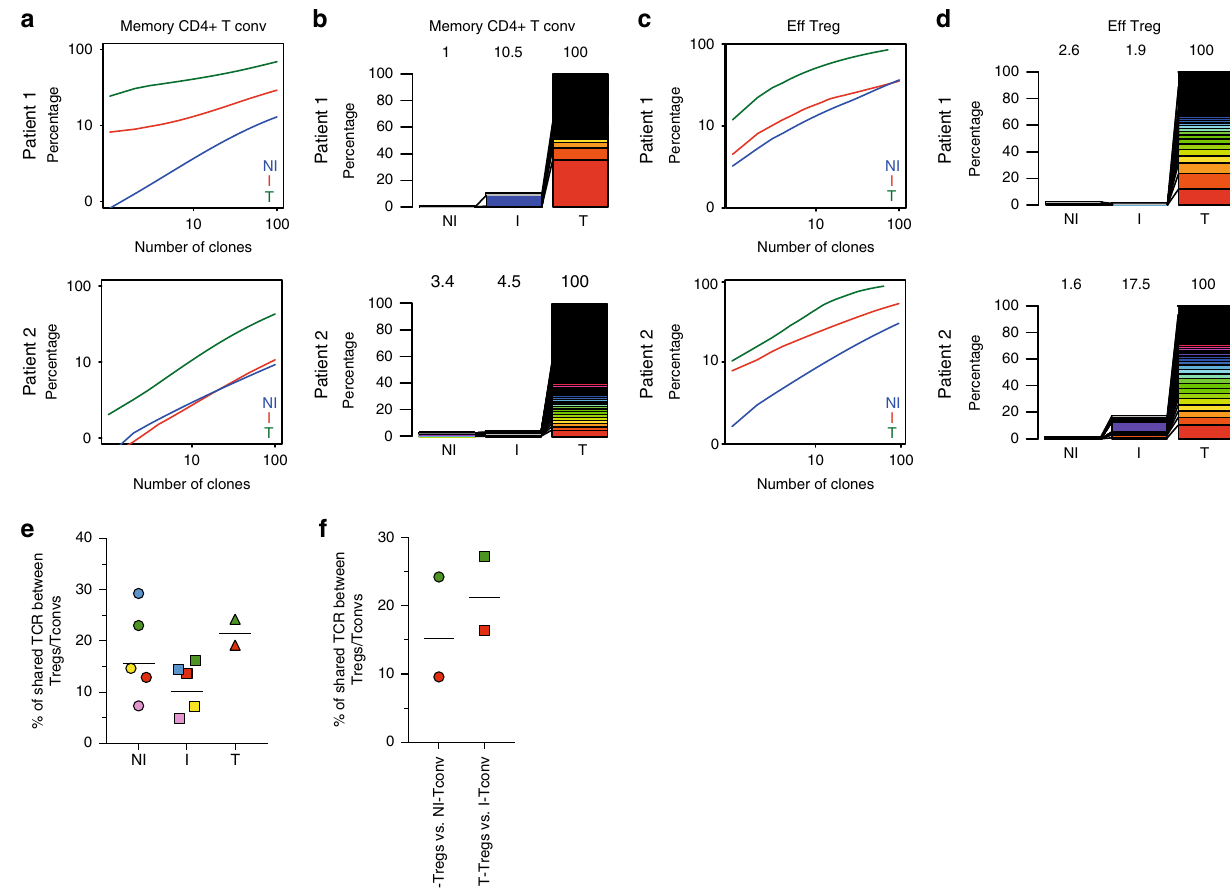
Fig. 5 Analysis of the TCR repertoire of CD4 + Tconvs and Tregs from NI and I TDLNs, and tumor. Next-generation sequencing-based high-throughput TCR- β CDR3 analysis of bulk sorted T-memory CD4 + Tconvs and Tregs from matched NI and I TDLNs and the primary tumor. Graphs a – d display the TCR- β CDR3 clones of memory CD4 + Tconv a , b ; or effector Tregs c , d . Graphs a , c show cumulative frequencies of from NI TDLNs (blue), I TDLNs (red), and the corresponding primary tumor (green), for two representative patients. Stacked bar chart b , d depict the usage frequencies of the top 100 tumor TCR- β CDR3 sequences and their distribution in matched NI and I TDLNs for two representative patients. Numbers in the graphs indicate percentage of shown TCR- β CDR3 sequences out of total TCR- β CDR3 sequences in the sample. e , f TCR repertoire overlap between Tregs and Tconvs. e Shown is the number (%) of unique TCRs shared between Tregs and Tconvs among all Treg clones in TDLN ( N = 5) and tumor ( N = 2). f Shown is the number (%) of unique TCRs shared between all tumor Tregs and Tconvs present in the NI or I TDLNs ( N = 2). Each symbol is a sample, and samples from the same patients are in the same